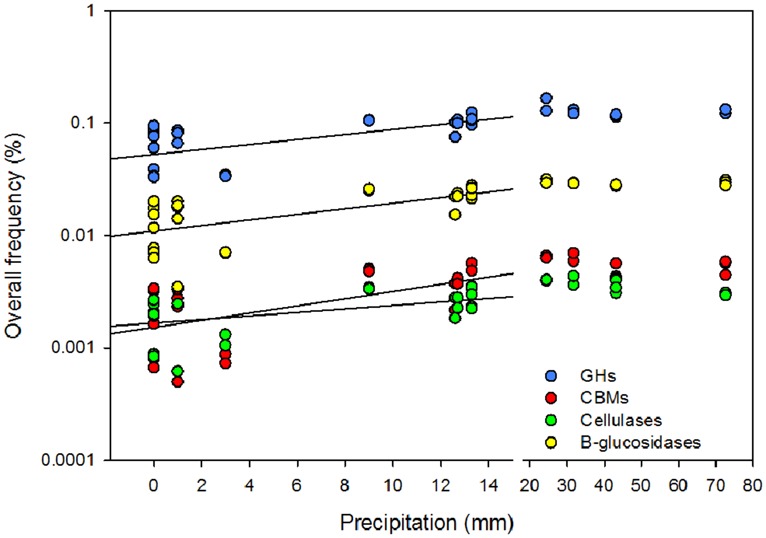
Effect of the cumulative precipitation during the 2 weeks prior to litter collection on the overall rarefied frequency of microbial glycoside hydrolases (GHs), carbohydrates binding modules (CBMs), β-glucosidases, and cellulases. Break in the x-axis was introduced to discriminate low from high precipitation.